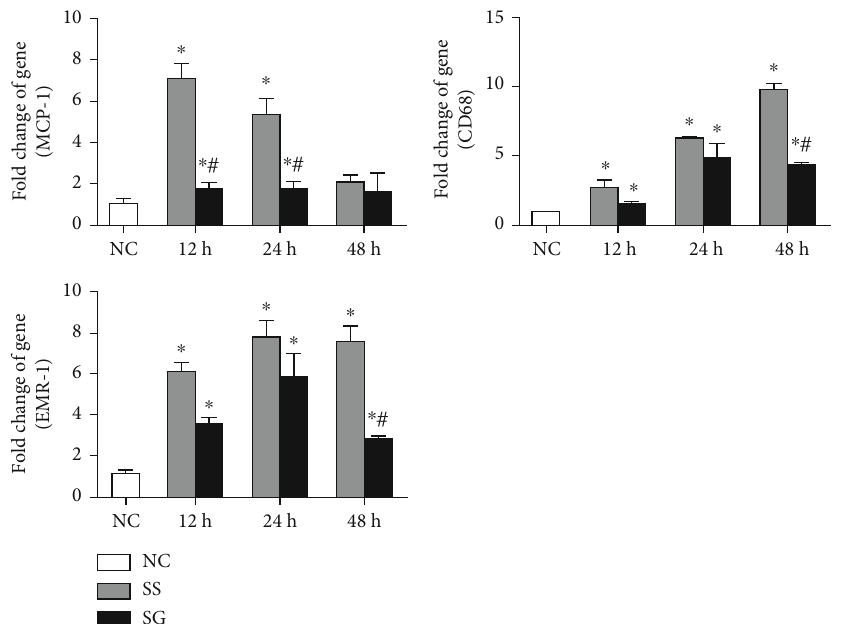
Figure 3: Messenger (m)RNA expressions of macrophage in fi ltration markers in kidney tissues. NC: normal control; SS: sepsis group with saline; SG: sepsis group with glutamine; CD68: cluster of di ff erentiation 68; EMR-1: epidermal growth factor-like module-containing mucin-like hormone receptor-like-1; MCP-1: monocyte chemoattractant protein-1. mRNA changes were quantitated and analyzed by a real-time PCR and were calculated by the comparative CT (2 - ΔΔ Ct ) method. mRNA expression levels in the normal control group were used as a calibrator. Values are expressed as the mean ± SEM . n = 8 for each group at 12, 24, and 48h after cecal ligation and puncture (CLP). Di ff erences between 2 sepsis groups at the same time point were analyzed by t -test. The comparison among NC and the sepsis groups at three di ff erent time points were analyzed by a one-way analysis of variance (ANOVA) followed by Tukey ’ s post hoc test. ∗ Signi fi cantly di ff ers from the NC group; # signi fi cantly di ff ers from the SS group at the same time point ( p < 0 : 05 ).